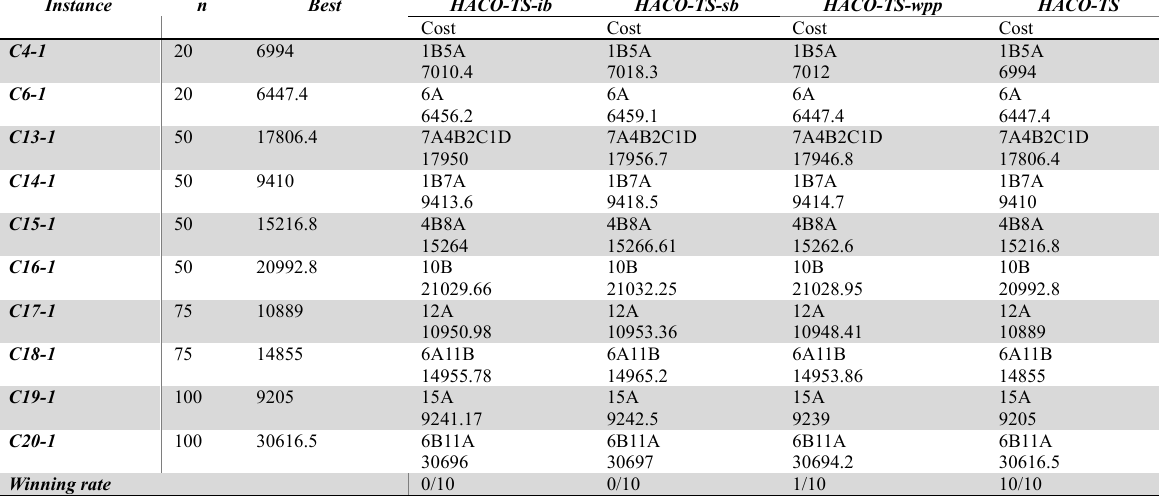
Comparison of the pheromone update